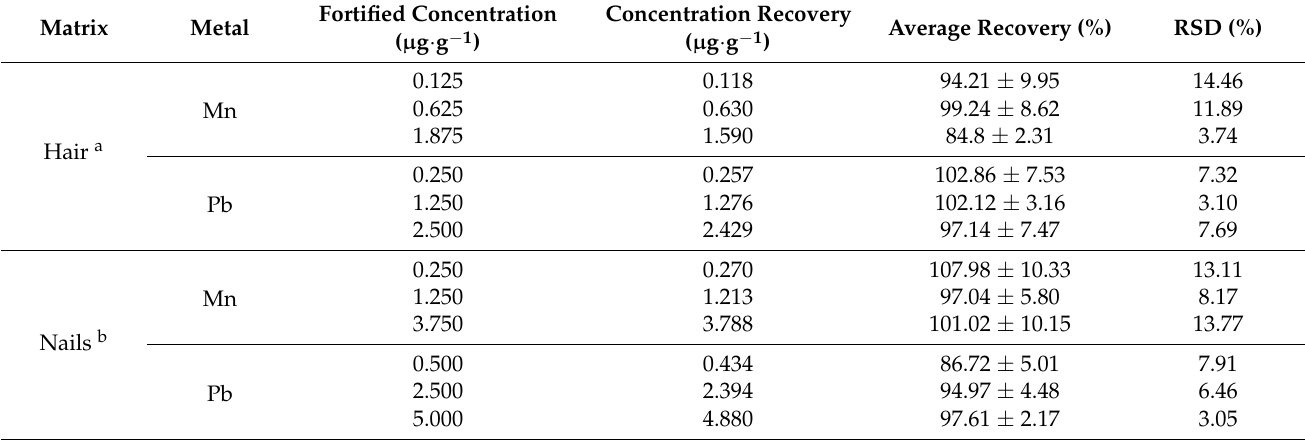
Table 6. Precision and Uncertainty